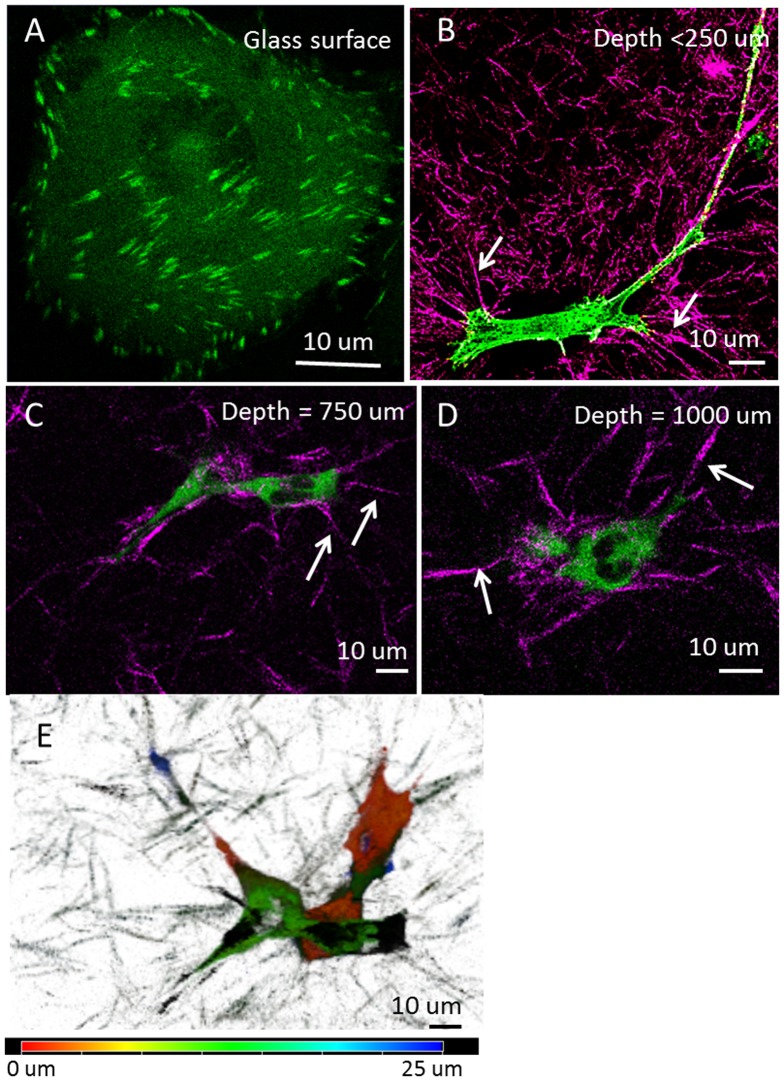
MDA-MB-231 cells in 3D type I collagen matrix.(A–D) 2-photon excitation raster scan images of MDA-MB-231 cells labeled with paxillin-EGFP (green) in type I collagen matrix (purple) at different depth from the glass surface, as indicated in each panel. Cells on the glass surface show focal adhesions at the cell borders (A), but there are no distinctive focal adhesions when cells are in collagen matrix (B–D, depth is the distance to the glass surface). However, collagen fibers were remodeled near the cells, showing more straight fibers toward the cell body as indicated by the white arrows, and collagen fibers away from cells were more randomly distributed, as shown in panel B. (E) Depth color-coding showing that MDA-MB-231 cells embedded in collagen matrix (750 µm above glass) have protrusions across tens of micrometers in depth, but the major cell bodies were about the same height.